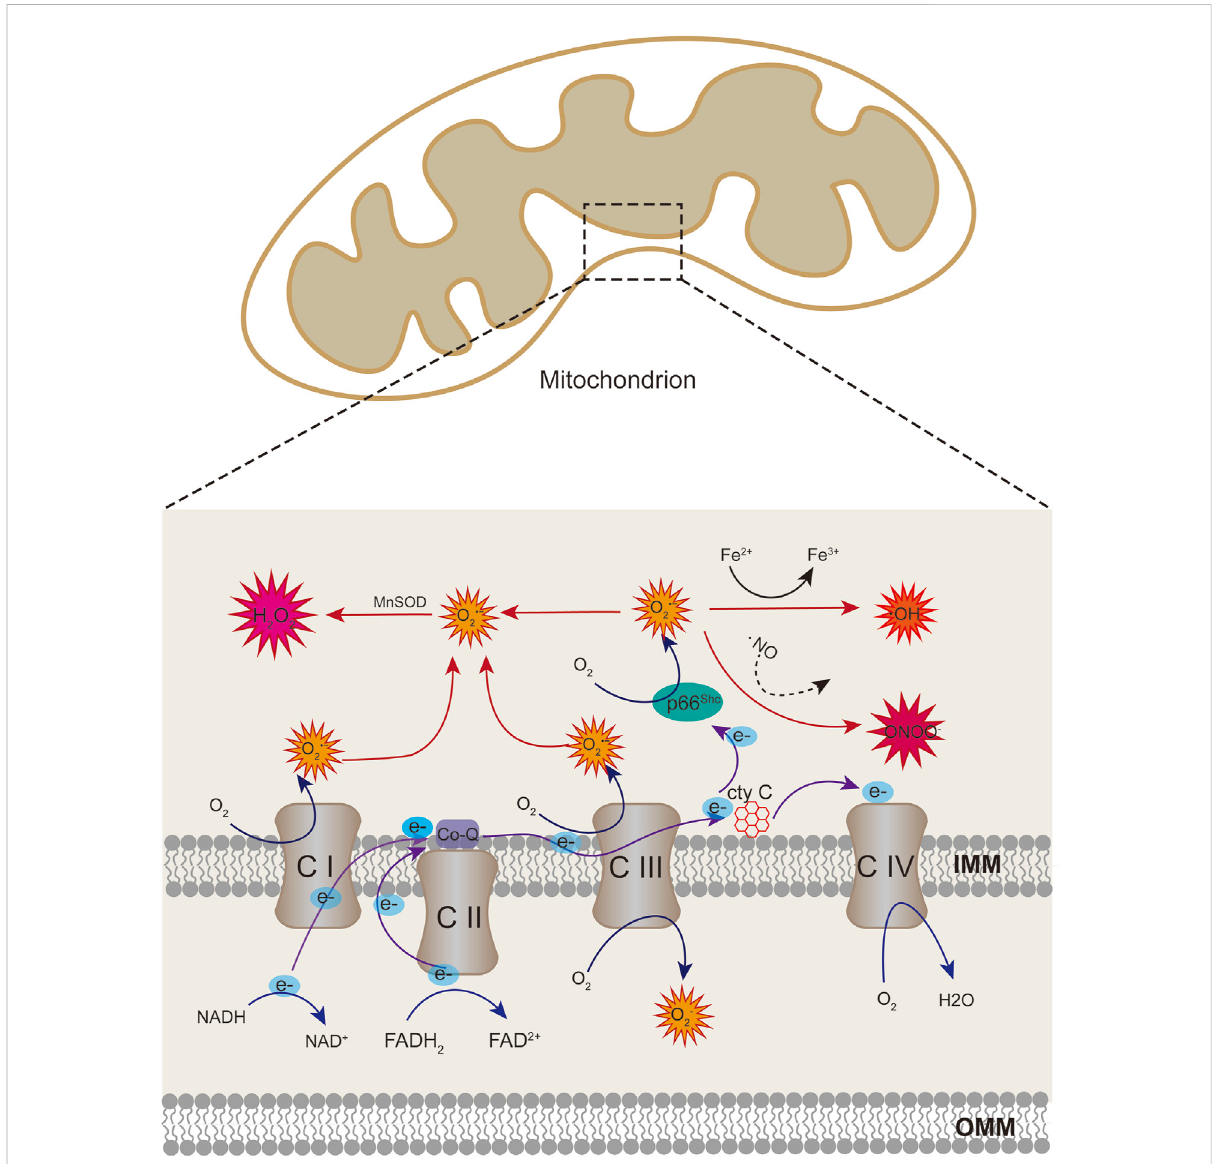
FIGURE 1 Schematic showing mitochondrial sources of ROS. Superoxide anion can be produced at the sites of complex I and III of the respiratory chain through electron transport. When cytochrome c transfers electrons from complex III to complex IV, p66Shc can subtract complex III-derived electrons from cytochrome c, leading to cytochrome c oxidized and producing superoxide anion. Superoxide anion can be converted to hydrogen peroxide (H2O2) by superoxide dismutase enzymes (SOD). Superoxide can also react with nitric oxide (NO) to produce peroxinitrite (ONOO). Hydrogen peroxide generate hydroxyl radicals in the presence of transition